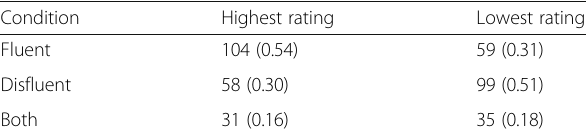
Table 1 Number of participants (proportion in parentheses) across both experiments who assigned their highest and lowest hirability rating to a job candidate from a fluent video, disfluent video, or both ( N =